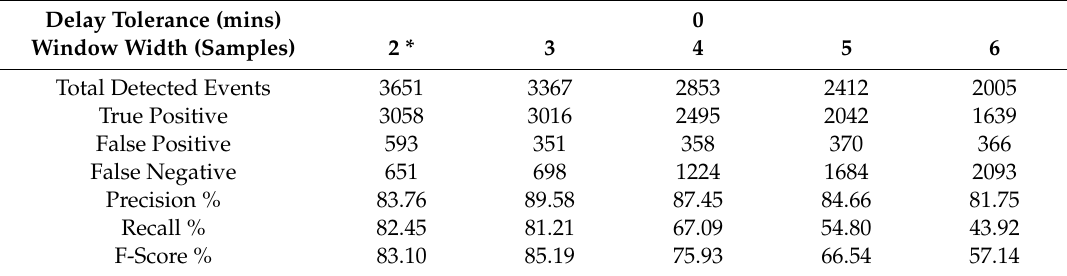
Table 3. Performance evaluation in the context of window